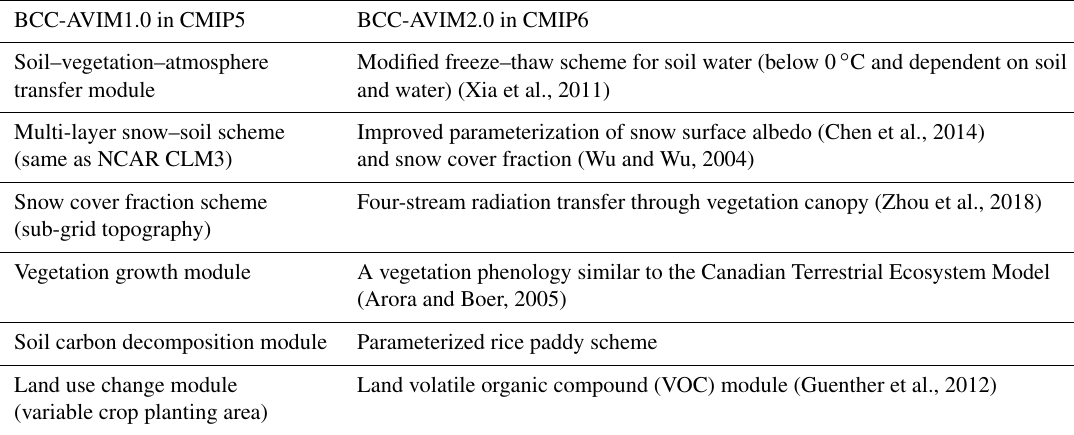
Table 3. Main physics schemes in BCC-AVIM